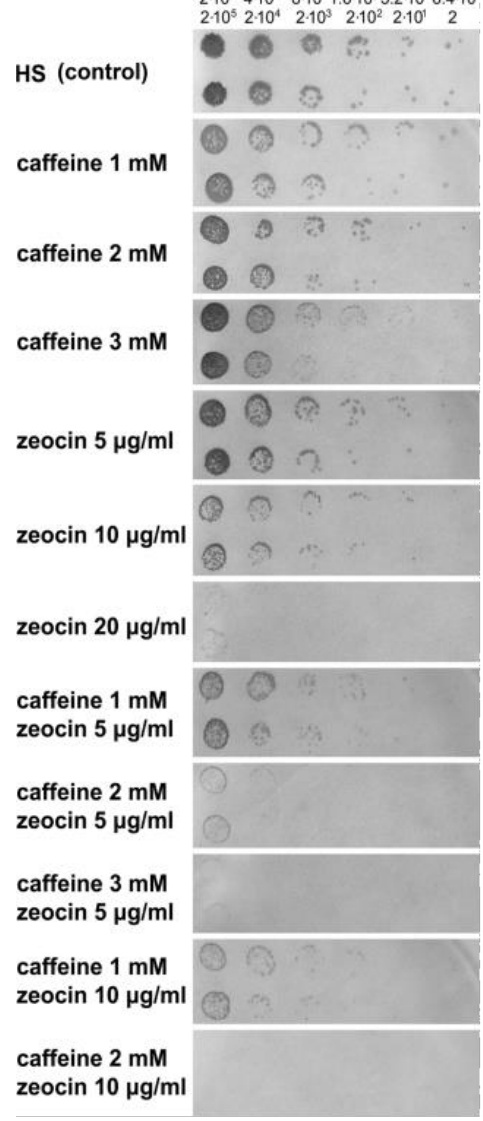
Figure 2. Survival of C. reinhardtii cells on caffeine and zeocin. Plate assay with serially diluted cells spotted either on HS nutrient medium free of chemicals (HS), used as a control, or onto HS nutrient medium supplemented with different concentrations of caffeine and zeocin. Two different serial dilutions are shown; upper strip—dilution by a factor of five, bottom strip—dilution by a factor of 10, approximate concentrations of the cells in each spot are indicated above; concentrations of the drugs are indicated at the side of each strip.